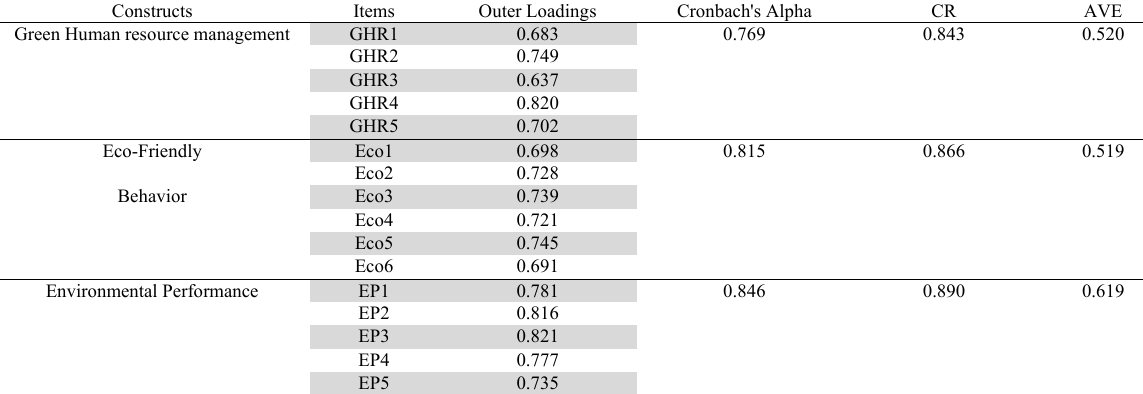
Indicator Loadings, Internal Consistency Reliability, and Convergent Validity Constructs